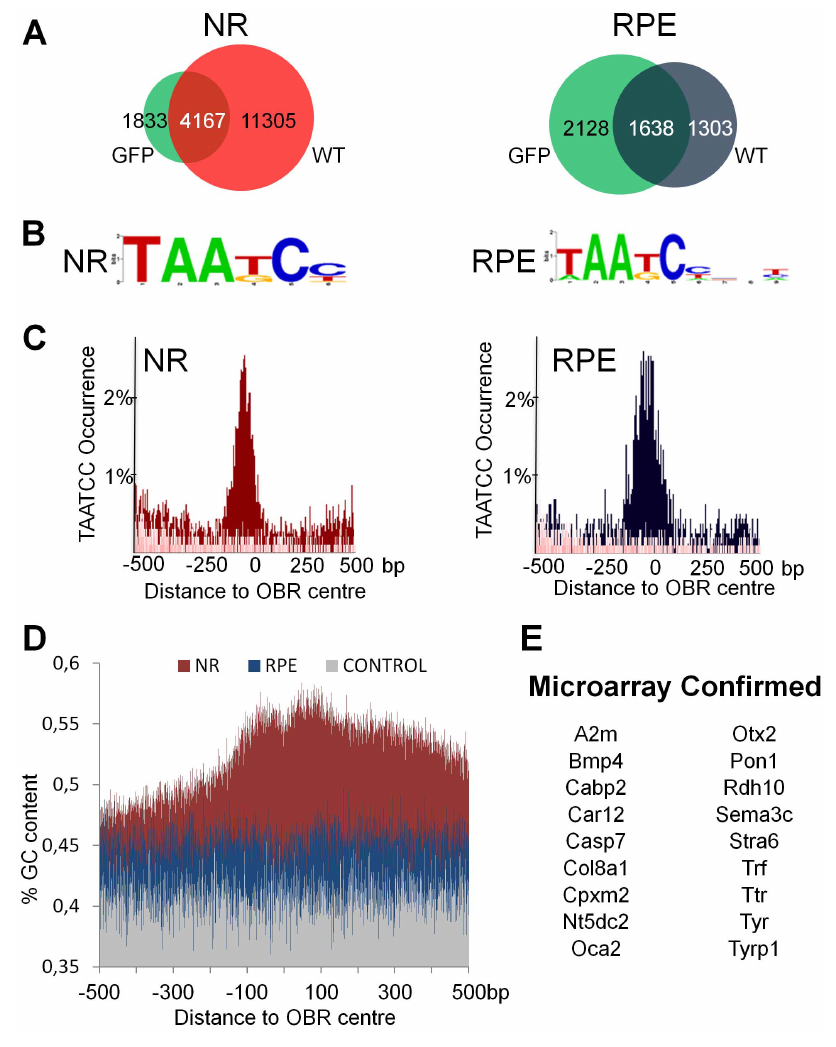
Figure 2. Dual ChIP-seq assays identify relevant neural retina and RPE OBR core sets. A. Venn diagrams showing the overlap of peaks identified in both ChIP-seq assays in each tissue. Intersections of GFP (green) and WT (red in NR, blue in RPE) assays represent two core sets of 4167 and 1638 binding sites in the NR and in the RPE, respectively. B. Motif enrichment analysis on the core datasets. Shown is the highest enriched TAATCC Otx2 binding consensus motif. C. Distribution of the TAATCC motif in 1 kb of genomic sequence around the centre of the core set of OBRs. D. GC content 1 kb around the centre of Otx2 bound regions in NR (red) and RPE (blue) compared to a random selection of 1000 regions in the genome (grey). E. RPE specific microarray confirmed genes with a called peak in their